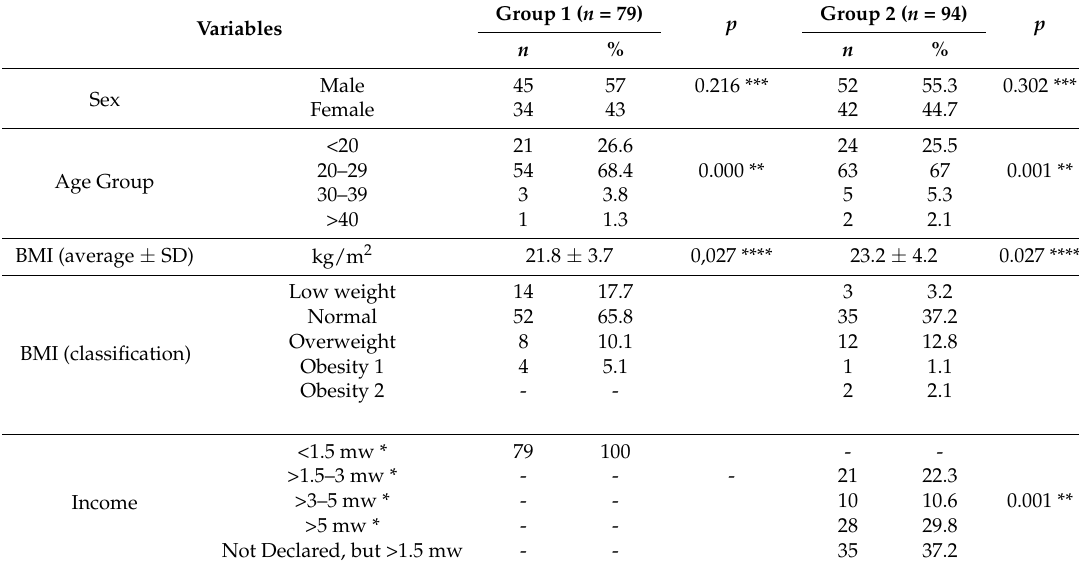
Table 1. Anthropometric profile, socioeconomic and demographic variables for both groups of students, consumers at the University